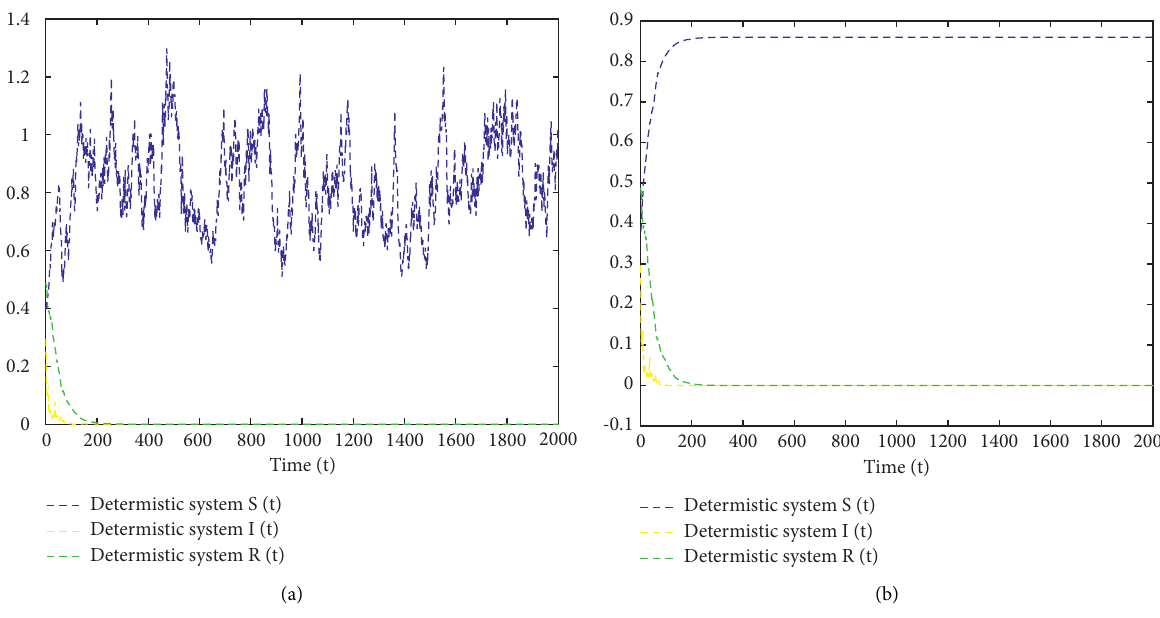
� 0 . 2, and σ � 0, respectively. 1 1